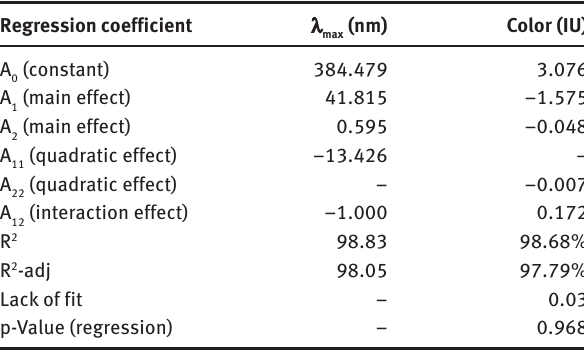
Table 4: The significance probability of regression coefficients for the final reduced